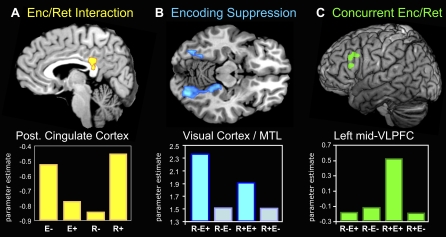
fMRI ResultsFor the purpose of illustration, all activations are shown at p < 0.005.(A) Interaction between stage (E/R) and outcome (+/-) in PCC, E– = (R–E– and R+E–), E+ = (R–E+ and R+E+), R– = (R–E– and R–E+), R+ = (R+E– and R+E+).(B) A thre-step analysis indicated encoding suppression in the visual cortex and medial temporal lobe during concurrent retrieval. In step 1, a “localizer” task identified regions related to scene processing. In step 2, we defined encoding success areas within the remaining regions using the contrast R–E+ > R–E–. In step 3, we tested whether the mean encoding success activity of the remaining regions was reduced when successful retrieval happened concurrently.(C) Greater activity in left mid-VLPFC during concurrent, as compared to separate, successful encoding and retrieval (R+E+ > R+E– and R–E+). Bar graphs indicate the mean of all activated voxels (p < 0.001, uncorrected).